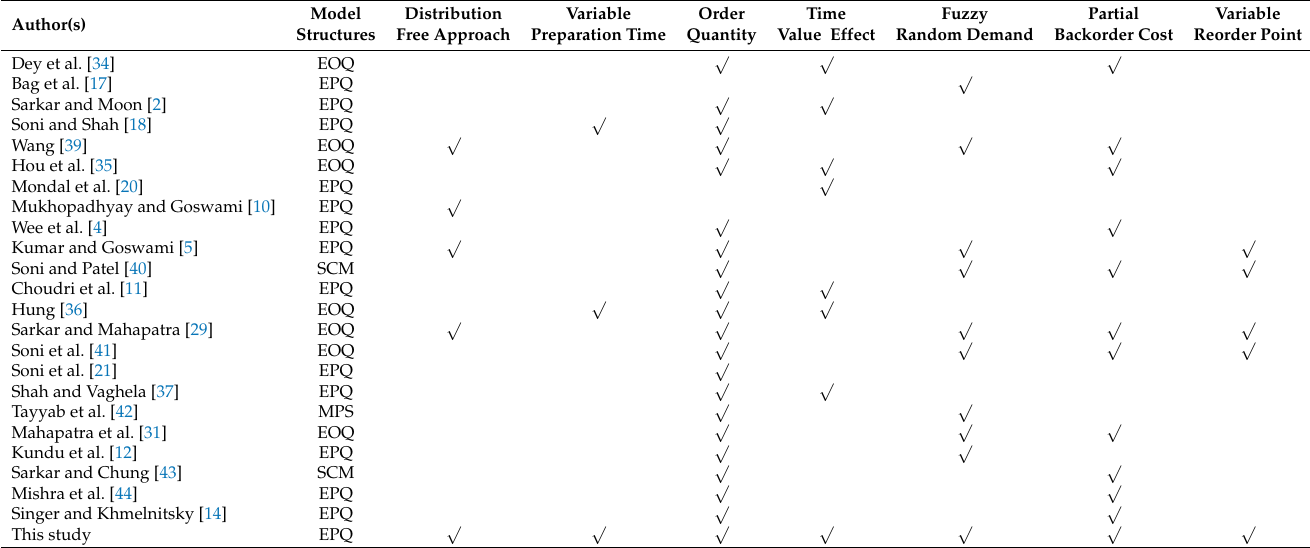
Table 1. Comparison of the contributions of different